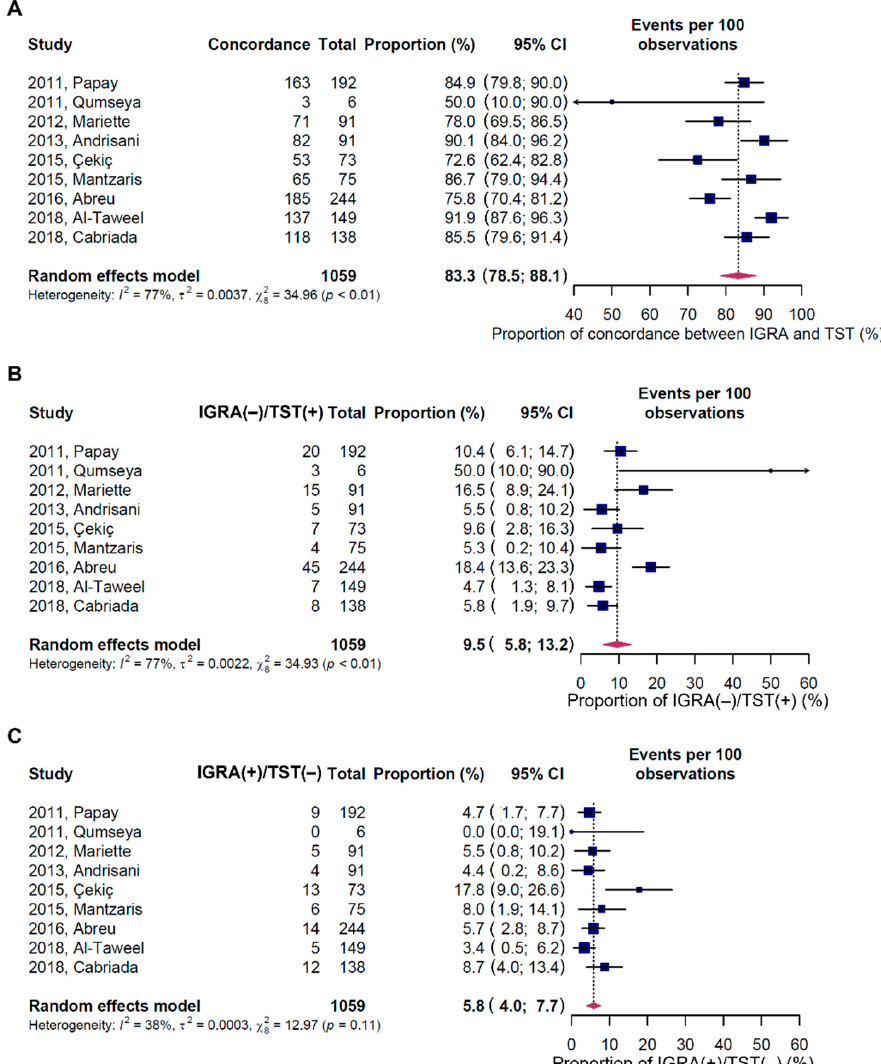
Figure 5. Concordance rates between IGRA and TST results. ( A ) Concordance, ( B ) IGRA-negative and TST-positive results, and ( C ) IGRA-positive and TST-negative results. The subscript number following χ 2 indicates the degrees of freedom. IGRA—interferon γ release assay; TST—tuberculin skin test; CI—confidence interval.